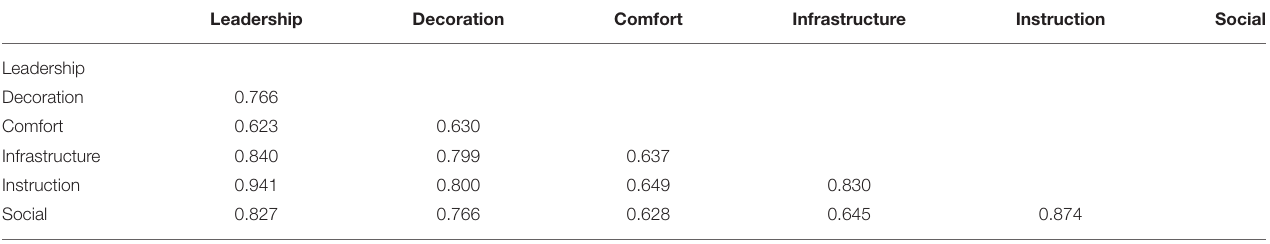
TABLE 5 | Correlation matrix of the subscales.